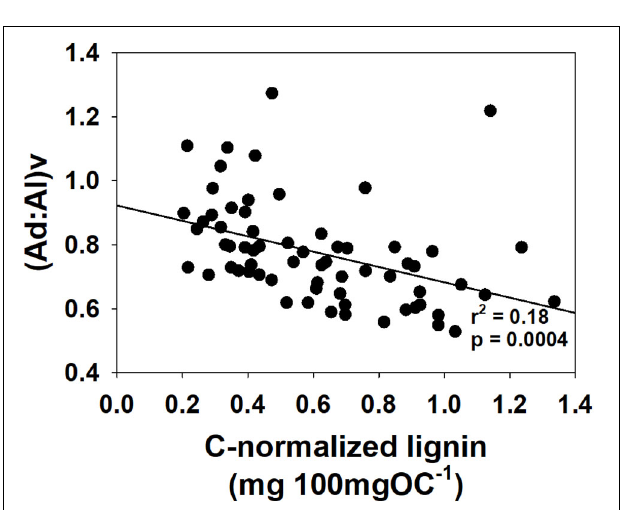
FIGURE 4 | Vanillic acid to vanillin ratios, (Ad:Al)v, vs. carbon-normalized lignin yields, (cid:51) 8 , for all data.